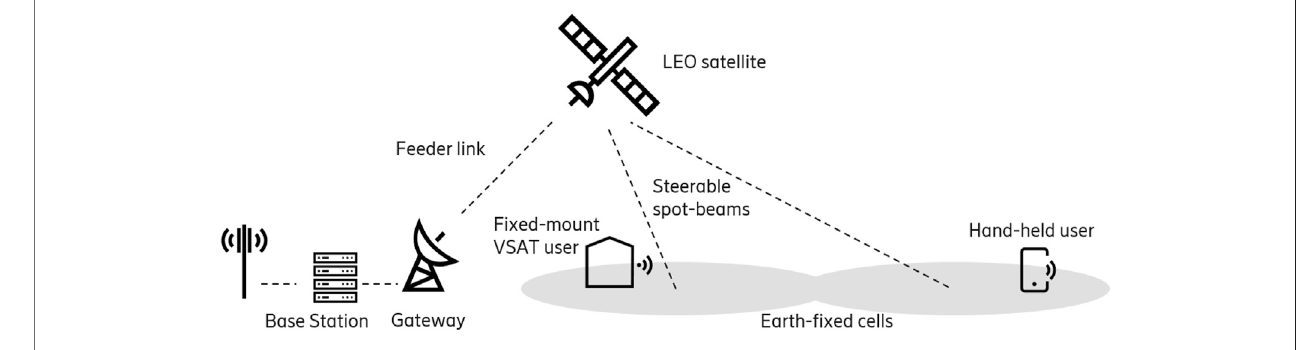
FIGURE 3 | NTN transparent architecture.